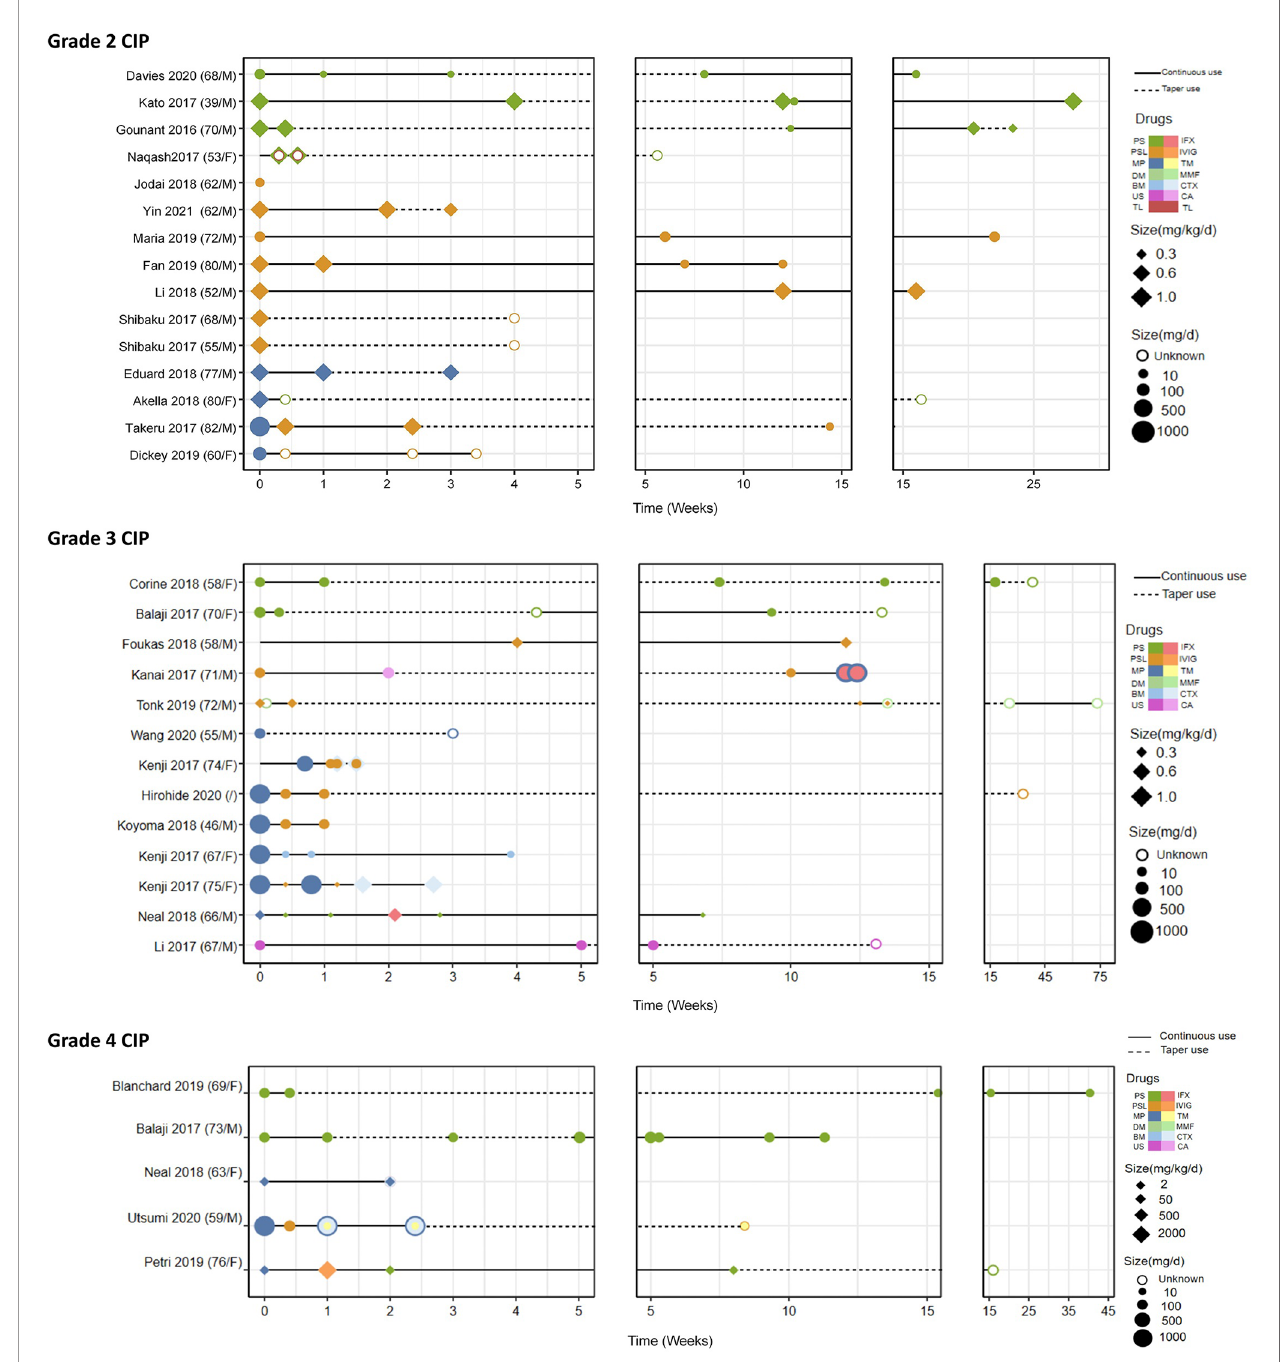
FIGURE 4 | The steroid therapy including every drug that every case utilized and the de fi nite continuous and taper time. PS, prednisone; PSL, prednisolone; MP, methylprednisolone; DM, dexamethasone; BM, betamethasone; US, unspeci fi c; TL, tocilizumab; IFX, in fl iximab; IVIG, immunoglobulin; TM, tacrolimus; MMF, mycophenolate mofetil or mycophenolic acid; CTX, cyclophosphamide; CA, cyclosporine